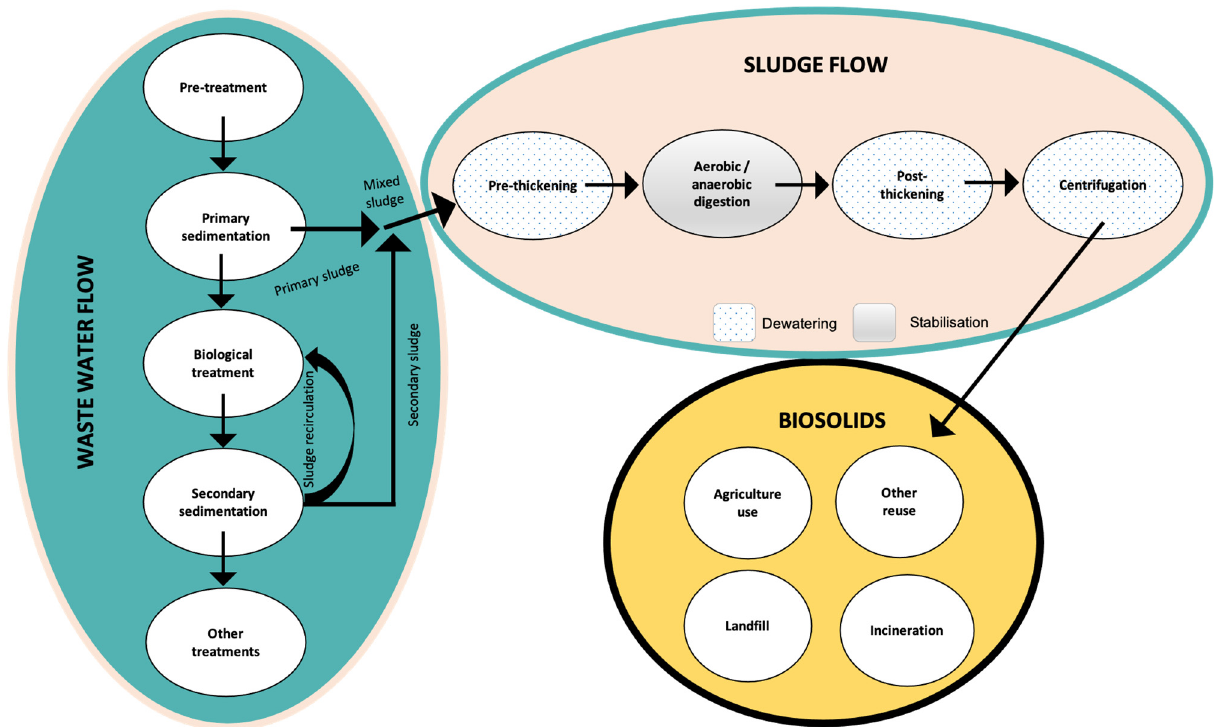
Figure 1. Scheme example of a conventional WWTP with a sludge line. Adapted from [15].